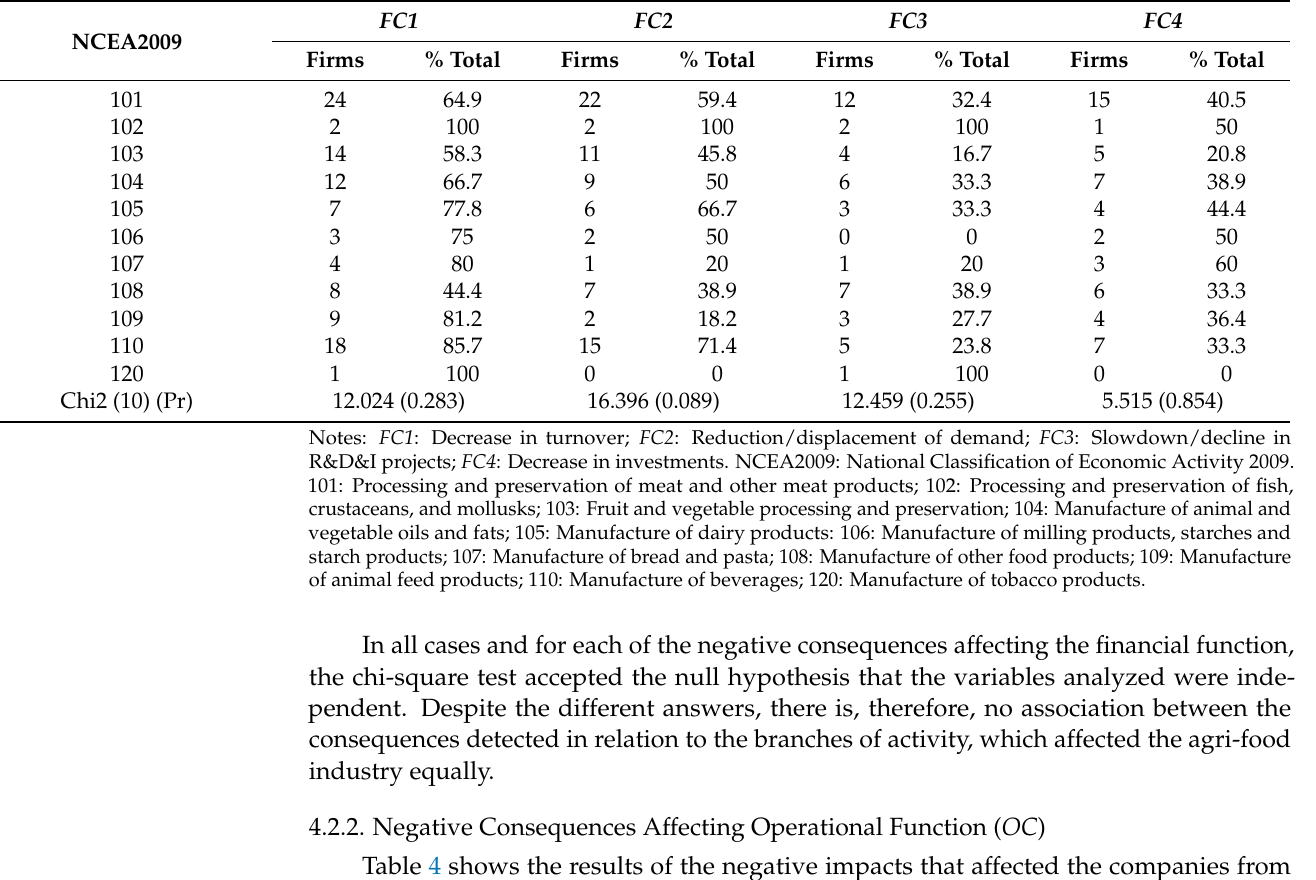
Table 3. Negative consequences affecting the financial function according to the branch of